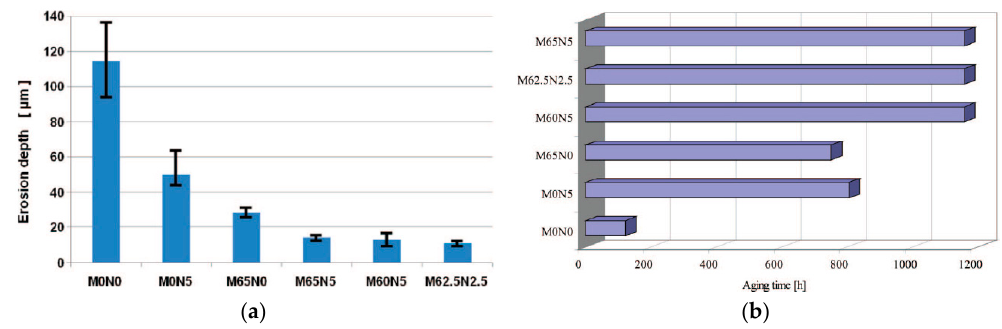
Figure 26. ( a ) Partial discharge erosion depths measured on neat epoxy resin (M0N0), 5 wt % nanoSiO